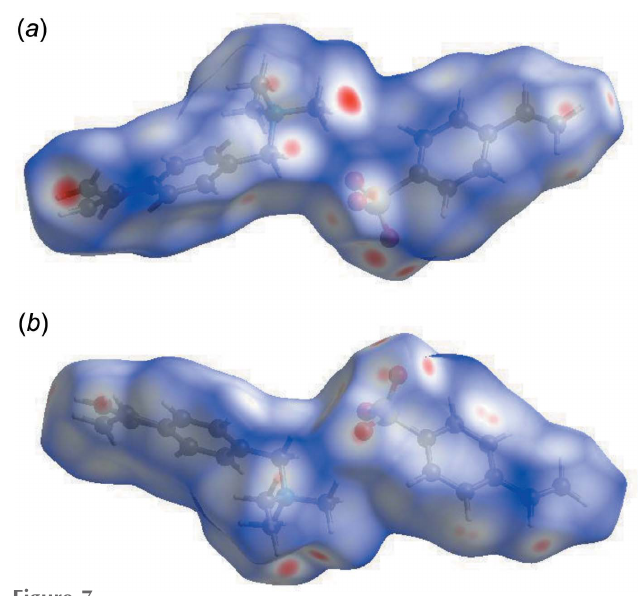
Figure 7 Hirshfeld surfaces of (1) viewed for opposite faces of the